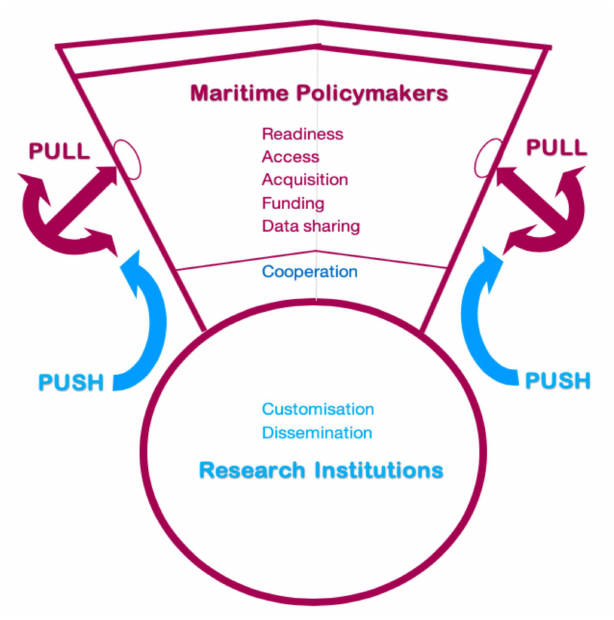
Figure 1. Research uptake push and pull improvement